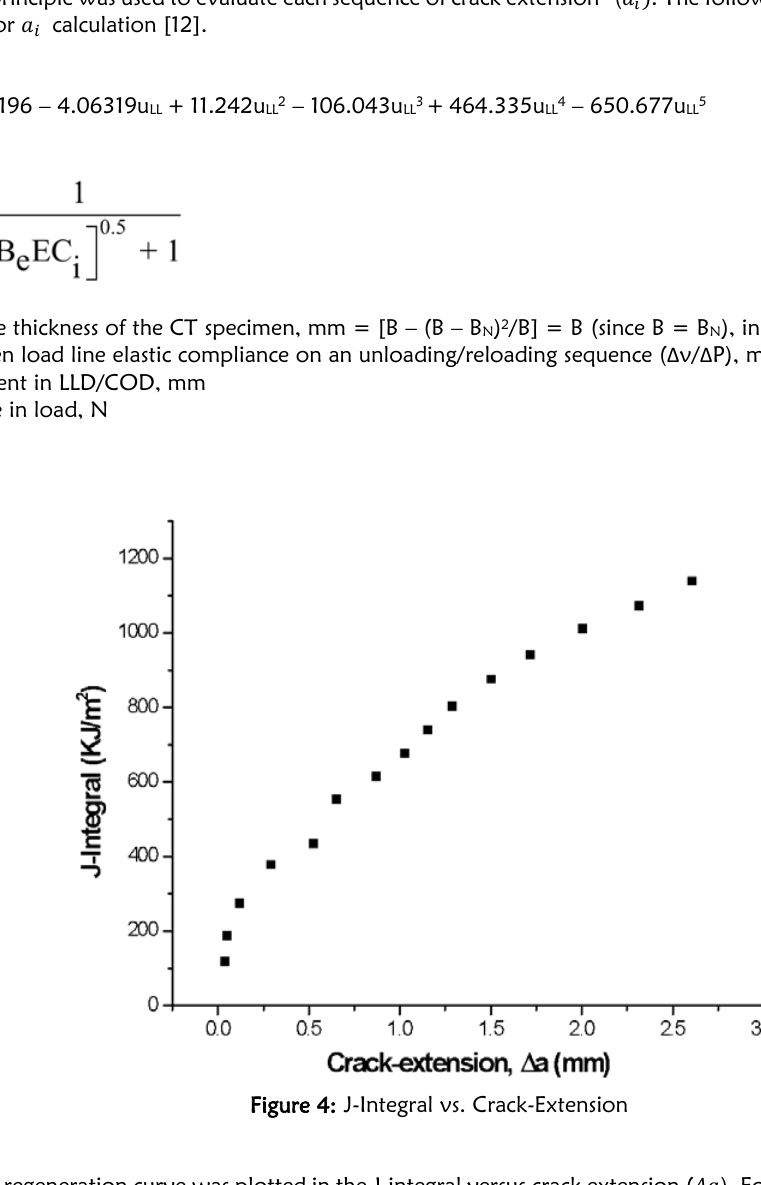
blunting line, 0.15 mm exclusion line, 0.2 mm exclusion line and 1.5 mm exclusion line were superimposed on the point lines between 0.15 mm exclusion line and blunting line. The intersection of the 0.2 mm exclusion line